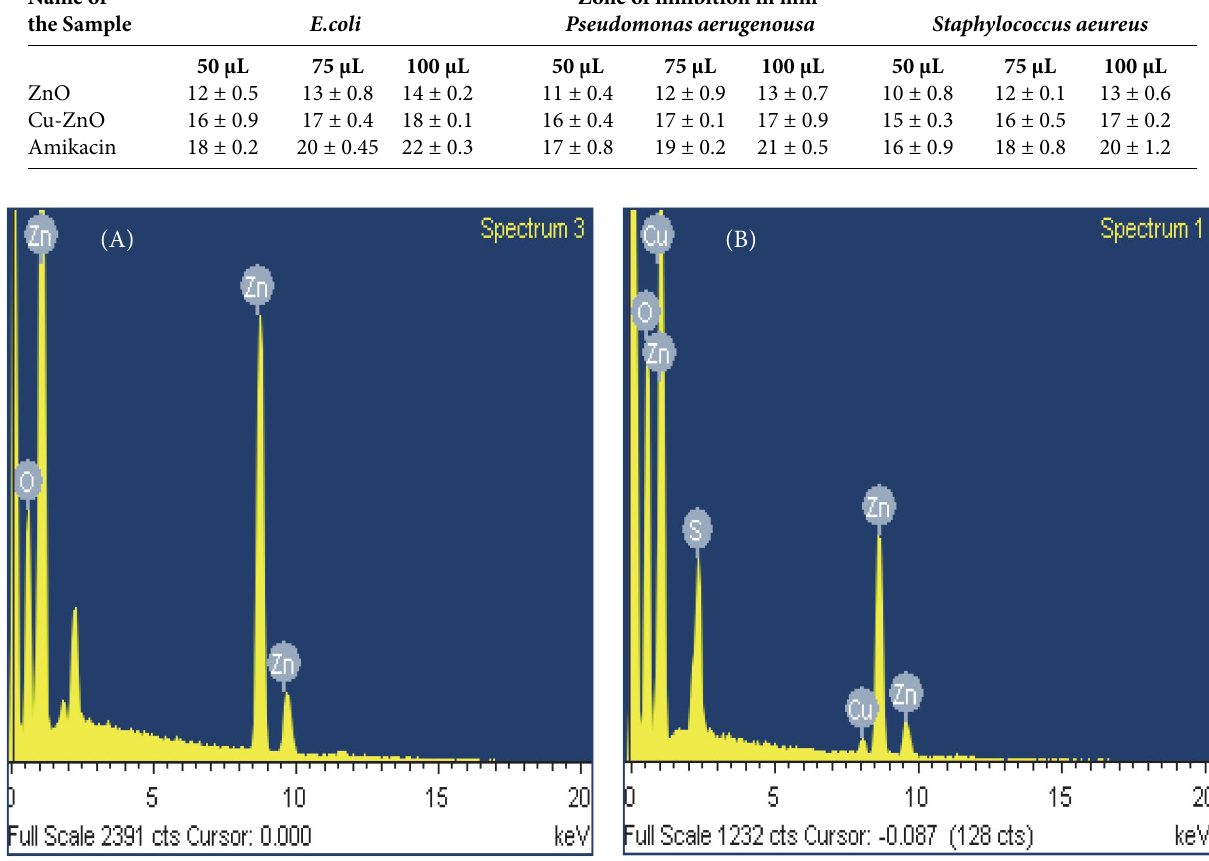
Table 1. Antibacterial activity of Cu-ZnO NPs Name